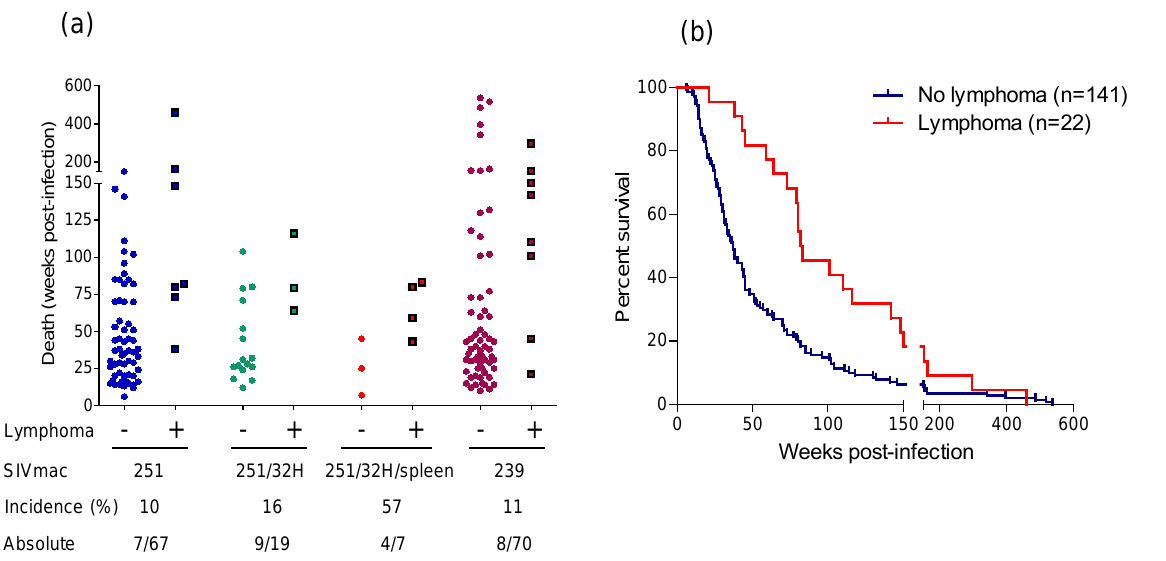
Figure 1. (a) Lymphoma incidence related to the utilized simian immunodeficiency virus stock. Each animal is depicted as an individual symbol. On the x axis, the occurrence of lymphoma is indicated by + and − in relation to the virus used for infection. Incidences of lymphoma cases in percent and the ratios of absolute numbers of lymphomas to number of animals included are given below. The y axis indicates survival time as weeks post-infection. Animals were euthanized with early AIDS-like symptoms. (b) Survival of monkeys infected with the different SIV stocks and sacrificed with early AIDS-defining disease without versus those with lymphoma development. Macaques euthanized with lymphomas survived on average longer than those without ( p <0.0001, Gehan–Breslow–Wilcoxon